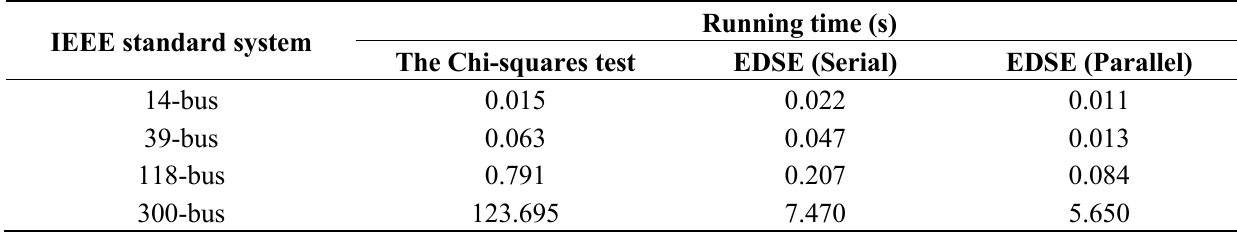
Table 9. Running time comparison.